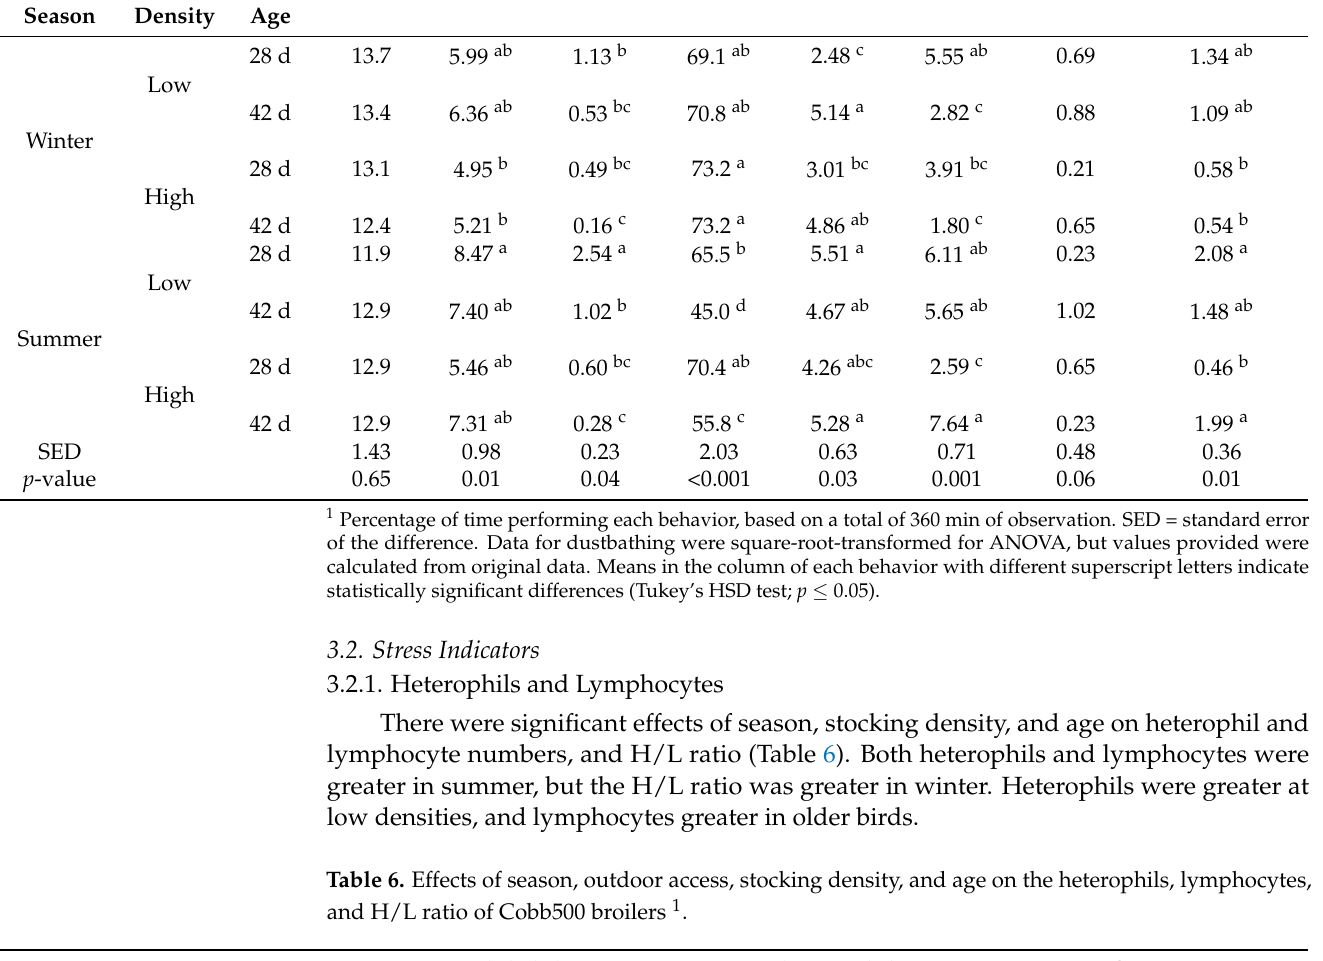
Table 5. Effects of the interaction between season, stocking density, and age on the behavior of Cobb 500 broilers 1 . Feeding Drinking LocomotionResting Standing Preening Dustbathing Foraging